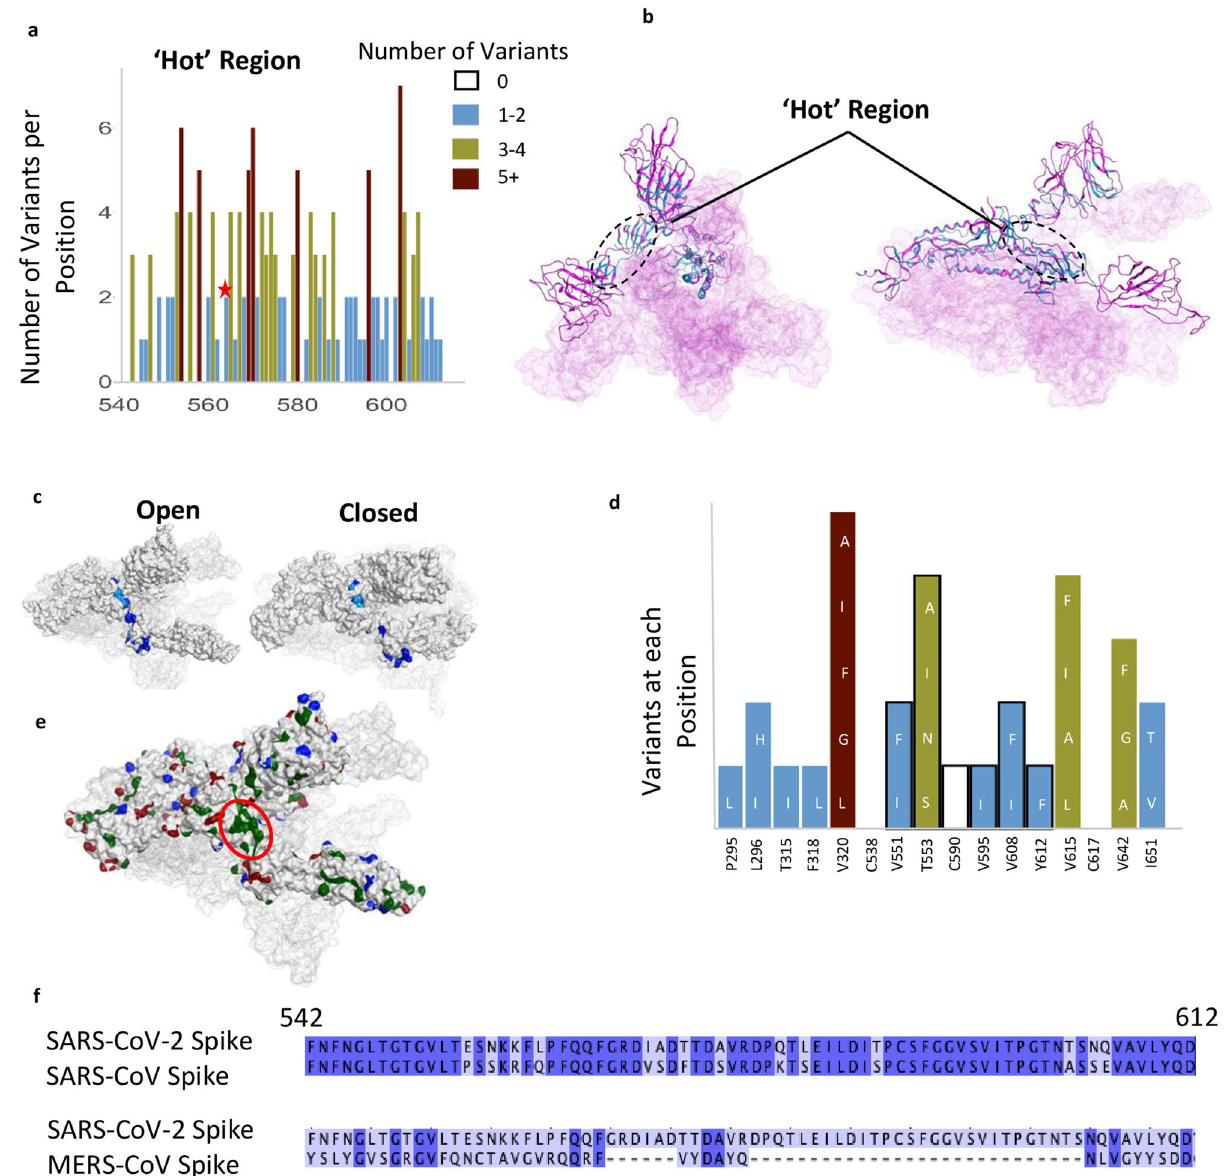
Figure 4. A relatively invariant (‘hot’) region in the S protein with no known function, identified by analyzing 441,168 individual virus sequences. ( a )The number of variants per position across the less-variable, ‘hot’ region with un-assigned function. The red star identifies the proposed ‘latch’, Q564 residue. ( b ) The hot region identified in the 3-D structure of S protein (open conformation). ( c ) Invariant ‘hot’ region in S protein with un-assigned function depicted in both the open (left) and closed (right) conformations. Dark blue denotes invariant amino acids and light blue denotes positions with 1–2 observed variants. This region becomes exposed after S protein gets activated by proteases. ( d ) Number of variants in hydrophobic patch with unassigned function. Positions outlined in black are part of the ‘hotspot’. ( e ) Some residues in the hotspot (shown in d ) are part of the largest hydrophobic patch (green, red ellipsoid) of S protein. Positive patches are highlighted in blue. Negative patches are highlighted in red. ( f ) Sequence identity between SARS-CoV-2 & SARS-CoV (81% identical), and SARS-CoV-2 & MERS-CoV (15%) in the ‘hotspot’. Dark blue denotes identical amino acid residues. Numbering corresponds to